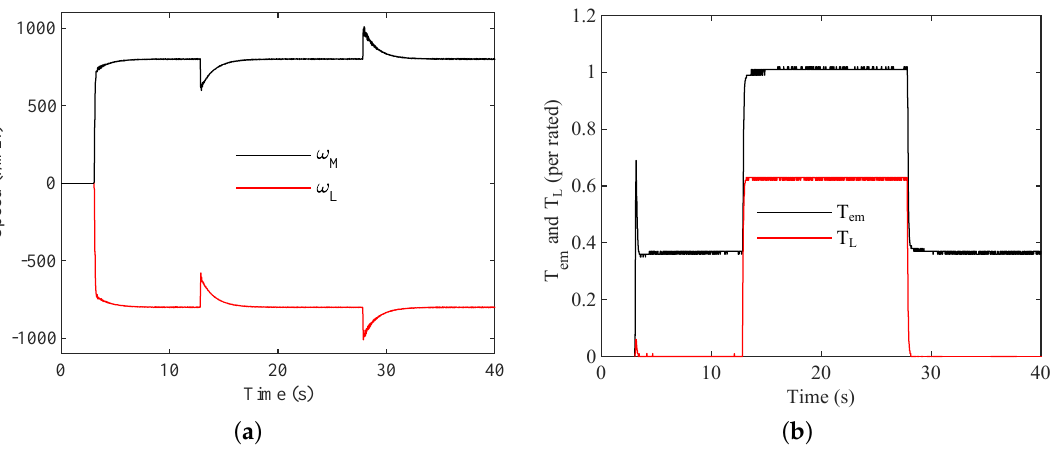
Figure 5. Experimental responses using the optimized controller with K a = 0.1 (speed reference ω ref is imposed at 1s; T L is set to 0%, 63%, and 0% of the pull-out torque at 1–13s, 13–28s, and 28–40s, respectively): ( a ) shaft speed of on both sides of the magnetic coupling; ( b ) T em and T L